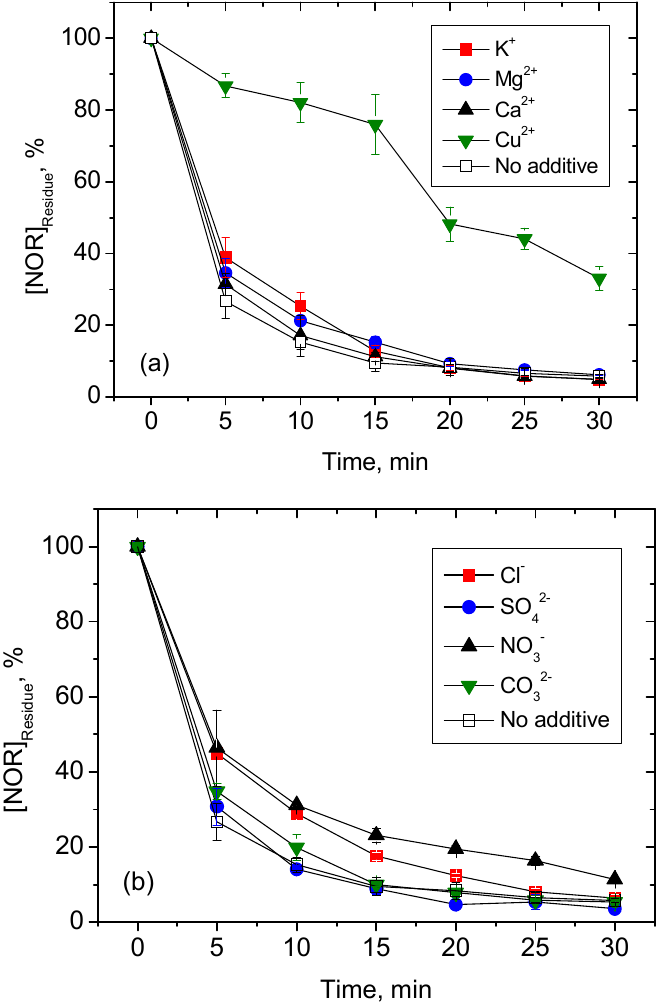
Figure 3. Effects of cations ( a ) and anions ( b ) on the degradation of NOR by the MW/UV process. (Experimental conditions: microwave power = 500 W, UV light intensity = 31.8 mW/cm 2 , maximum wavelength = 254 nm, [NOR] = 5 mg/L, [cation] = 5 mmol/L, and [anion] = 5 mmol/L). The degradation trend was also quite different from the NOR degradation without cations.